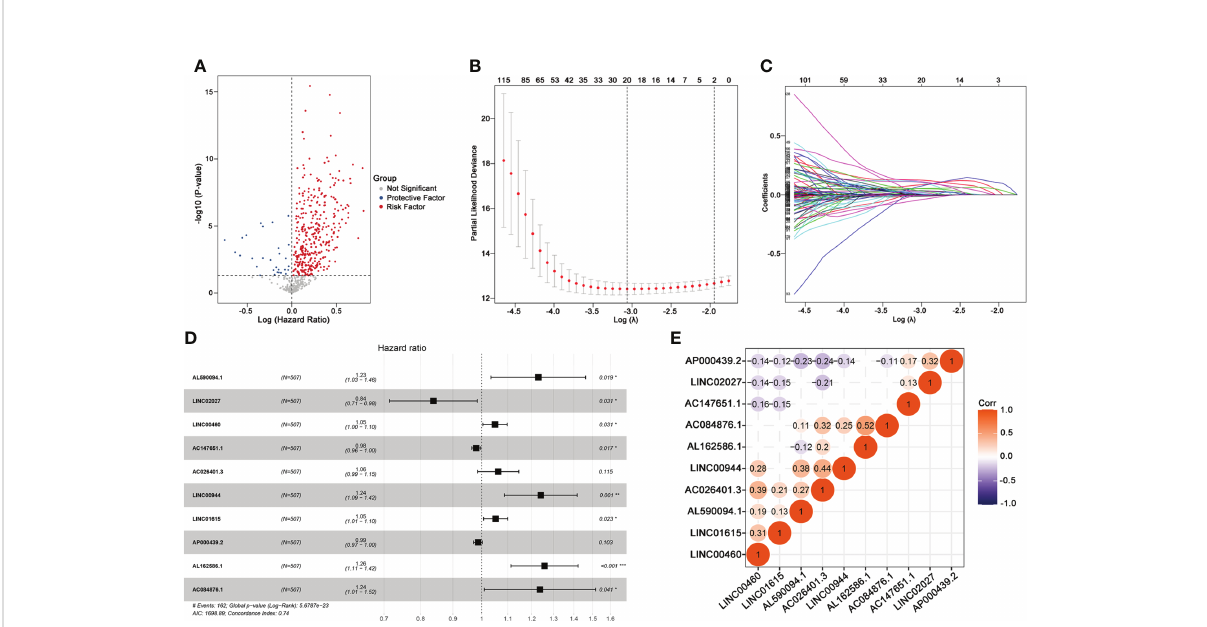
FIGURE 2 Identifying 10 TIL-related Long noncoding RNAs (lncRNAs)s. (A) Prognostic factors identi fi ed by univariate Cox regression. (B) Cross-validation for tuning parameter selection in the proportional hazards model. (C) Pro fi les of Lasso coef fi cients. (D) Multivariate Cox model of 10 TIL-related lncRNAs. (E) Correlation analysis between 10 TIL-related lncRNAs. “ Corr ” indicates the correlation coef fi cient generated by Pearson ’ s correlation analysis. * P < 0.05; ** P < 0.01; *** P <